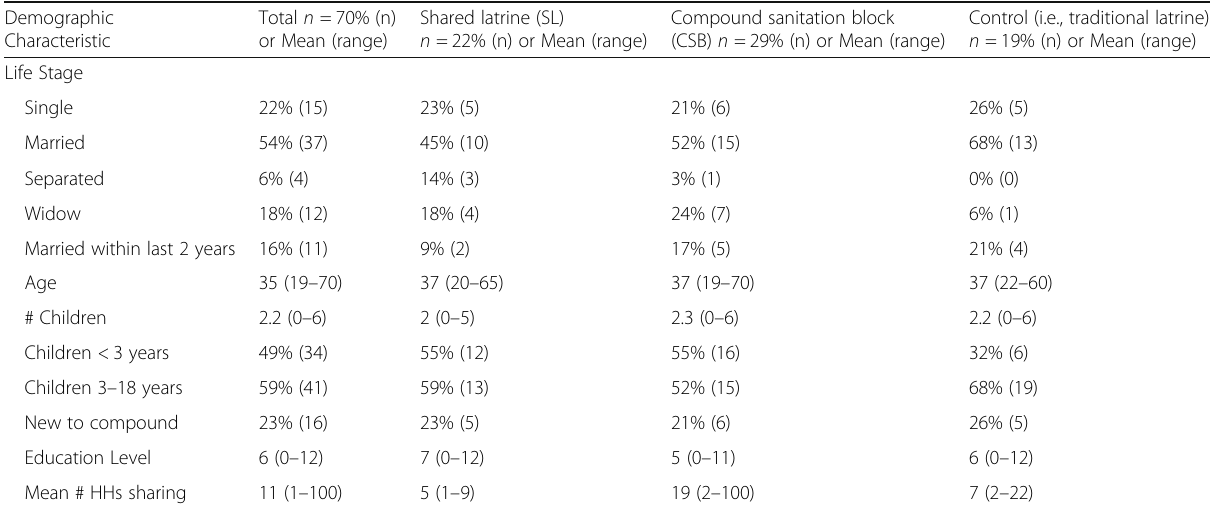
Table 1 Demographic characteristics of female IDI respondents using shared sanitation by latrine type Demographic